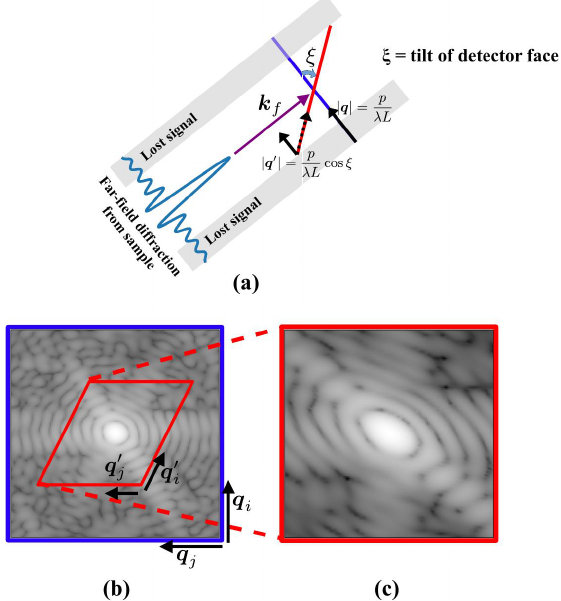
Figure 3. ( a ) Difference in the sampling step when a 1D line detector is placed perpendicular to the exit beam (blue), compared to when it is tilted with respect to this orientation (red). The effective sampling step | q (cid:48) | of the finite size of the pixels in the tilted case is smaller by a factor of cos ξ than the un-tilted case, as seen by the dashed arrow. ( b ) A similar scenario in the case of a 2D area detector, in which the general tilt of the detector is parameterized by not one, but three angles (see Appendix A and Table A2 for the specific parameterization and values used in this paper). This compares effective 2D signal coverage when the detector is perpendicular to the exit beam (blue) and tilted arbitrarily (red). ( c ) The ) and ( q (cid:48) ) denote the imaging plane sampling steps implied effective signal measured therein. ( q , q , q (cid:48) i j i j by the finite size of the area detector pixels, in the un-tilted and tilted